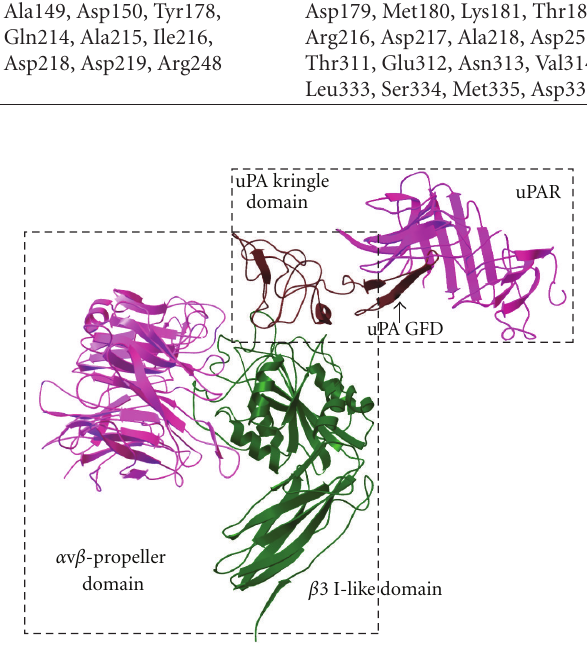
Figure 5: A model of integrin, uPA kringle, and uPAR complex. We performed docking simulation of the interaction between uPA kringle (PDB code 2URK) and integrin α v β 3 (PDB code 1L5G) using Autodock3. The simulation predicted the poses in which uPA kringle interacts with α v β 3. The uPA kringle-integrin complex was superposed with the ATF-uPAR complex (PDB code